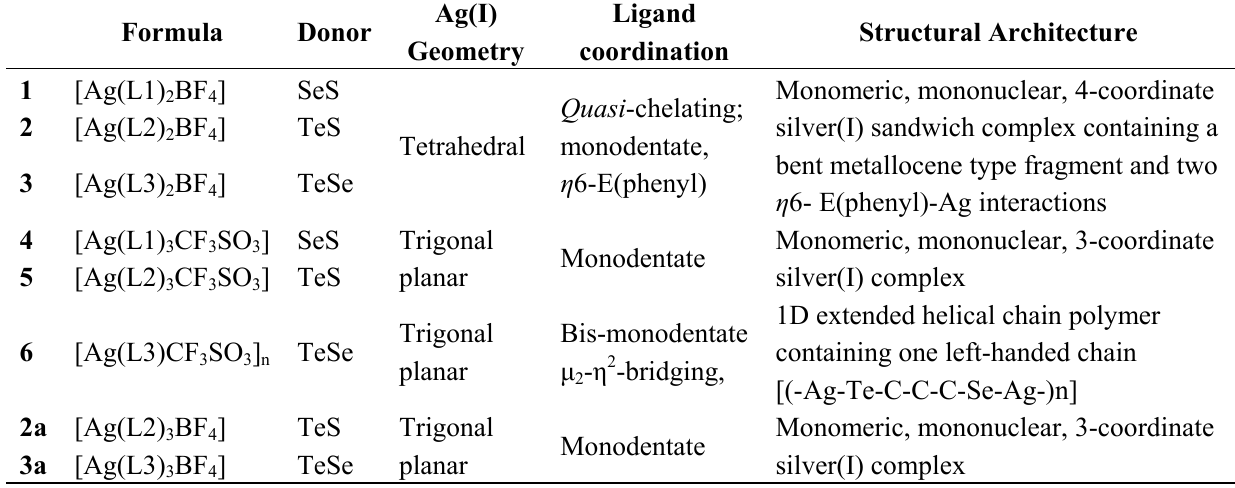
Table 6. Structural analysis of Ag(I) complexes 1 – 6 , 2a , 3a constructed from